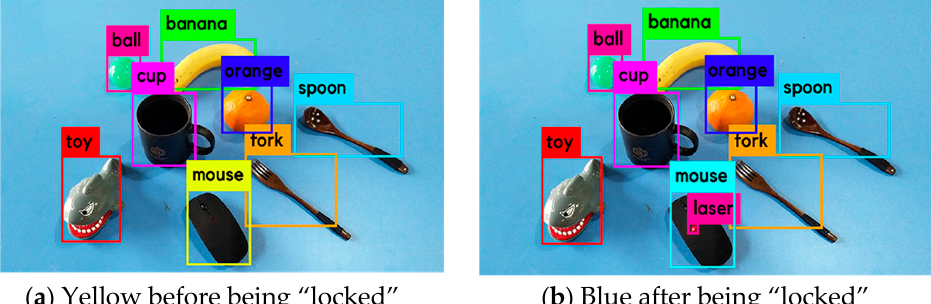
Figure 14. Frame colors of the mouse before and after being “locked”.